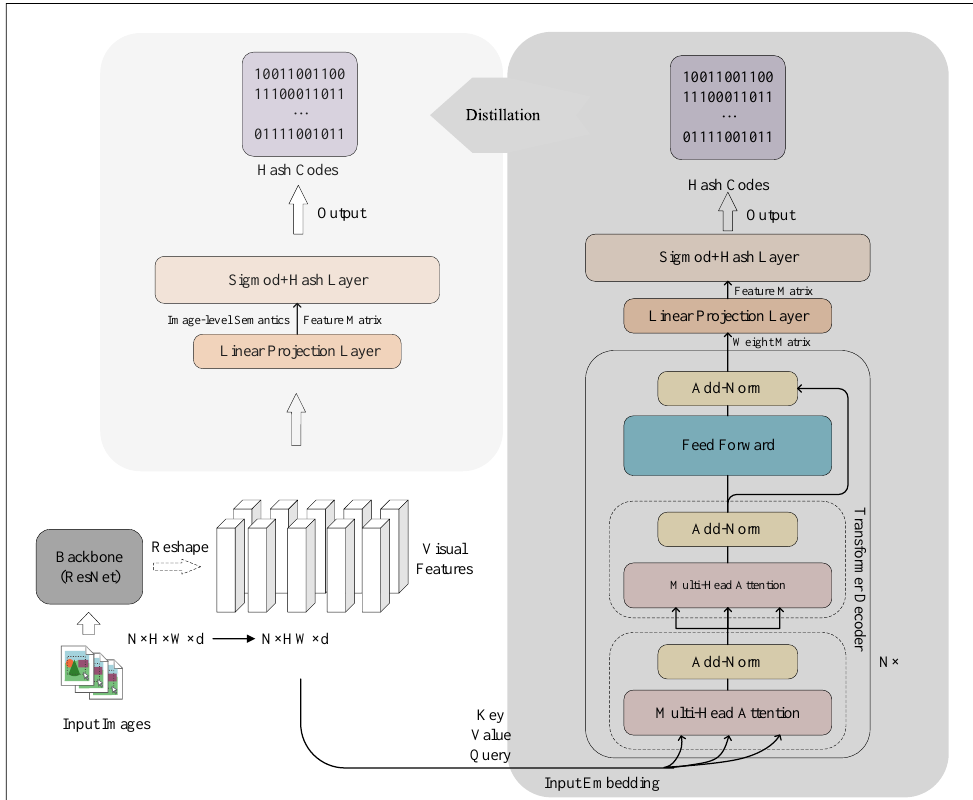
Figure 1. The overall architecture of our proposed